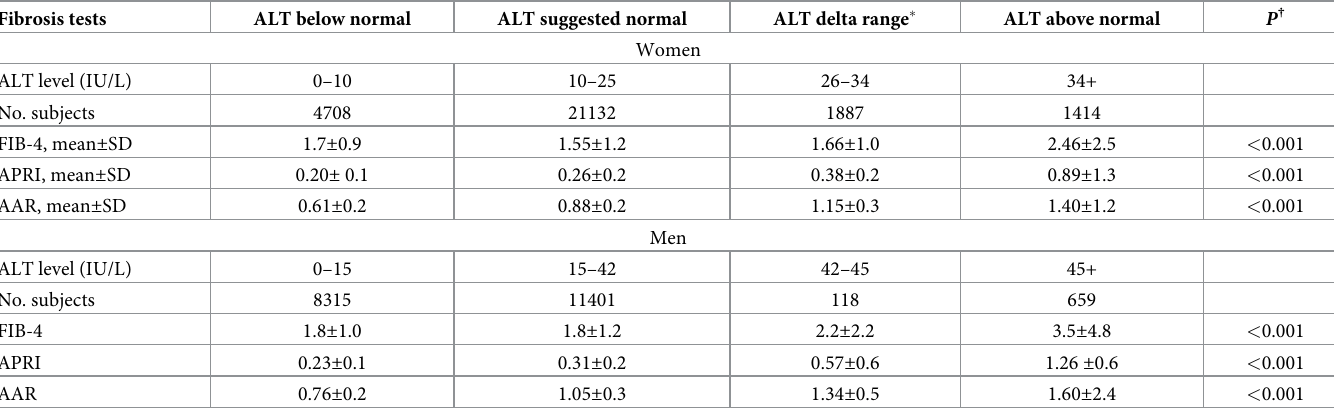
Table 3. Mean scores on fibrosis tests by ALT categories in women and men.